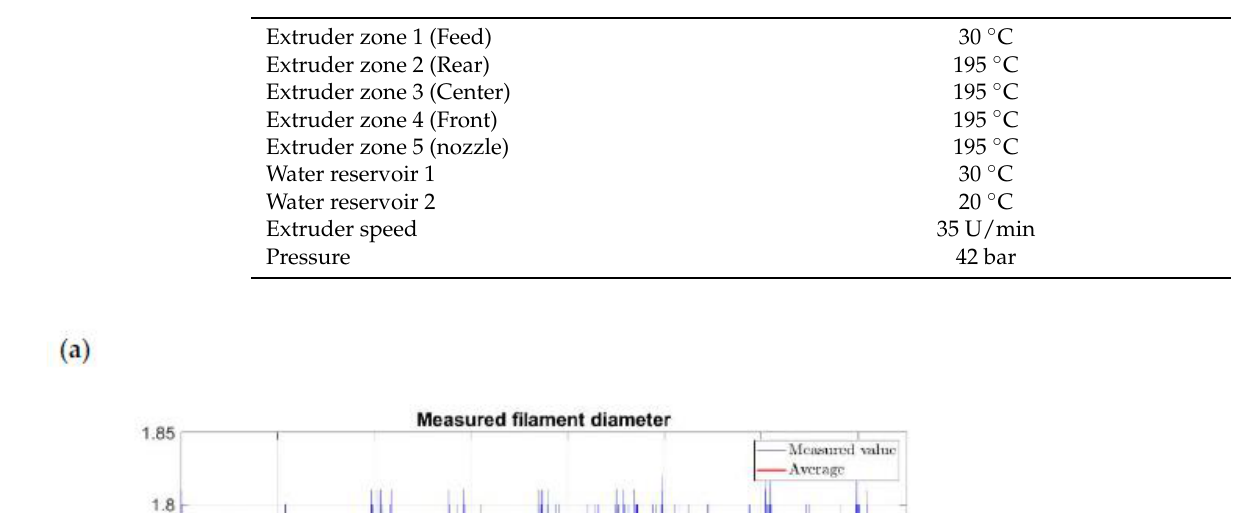
Table 1. Processing parameters for the filament production.